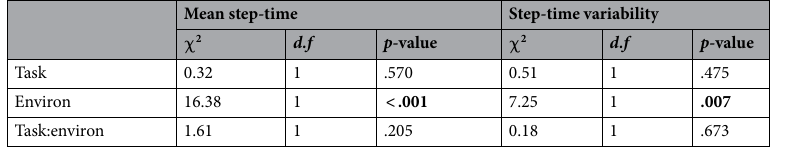
Table 3. Analysis of deviance tables for linear mixed-effects models evaluating mean step-time (ms) and step-time variability (natural log-transformed) during ambulatory conditions. Note χ 2 = Type II Wald χ 2 test statistic, d.f. = degrees of freedom, task = cognitive task condition (Count, Ignore), environ = environmental context (Field, Campus). Bold p-values indicate significance at an alpha threshold = .05.